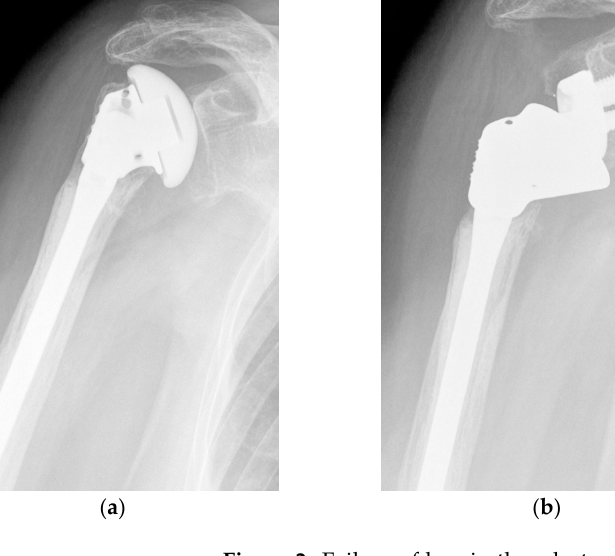
Figure 2. Failure of hemiarthroplasty and conversion to reverse shoulder arthroplasty. ( a ) Preoperative anteroposterior radiograph of a hemiarthroplasty with a firmly cemented stem showing insufficiency of the supraspinatus tendon and superior migration of the humeral head; ( b ) Postoperative anteroposterior radiograph of a conversion reverse shoulder arthroplasty with humeral stem retention; ( c ) Four-year postoperative anteroposterior radiograph showing prosthesis in situ.